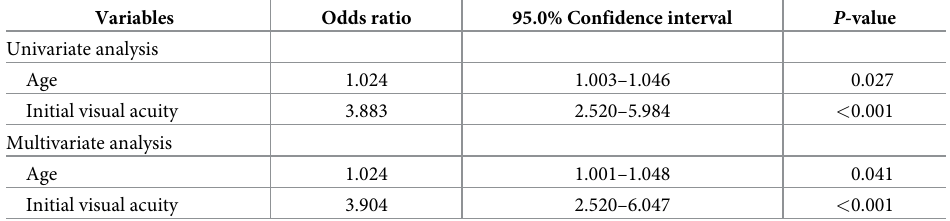
Table 6. Univariate and multivariate logistic regression analyses of risk factors associated with poor final visual